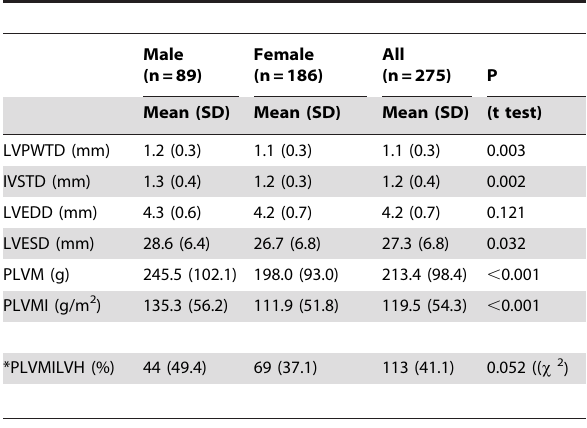
t = Two sample t test with equal variance. x 2 = Pearson chi squared test.